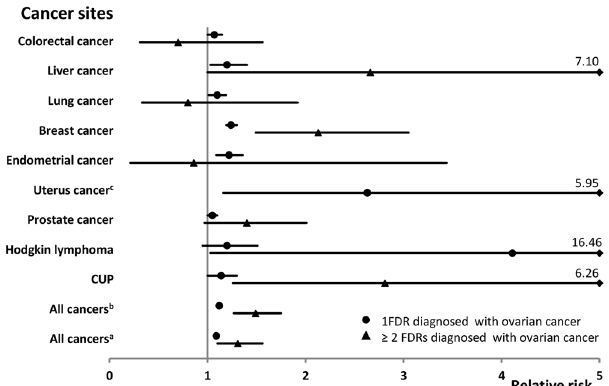
Figure 3. Other cancer risk when only one or at least two first-degree relatives were diagnosed with ovarian cancer. Only significant cancer sites are shown. CUP: cancer of unknown primary; a all cancers include ovarian cancers and all other cancers; b all cancers include all other cancers except ovarian cancer. FDR, first-degree relative; c cancer of other parts of uterus, including chorionepithelioma.